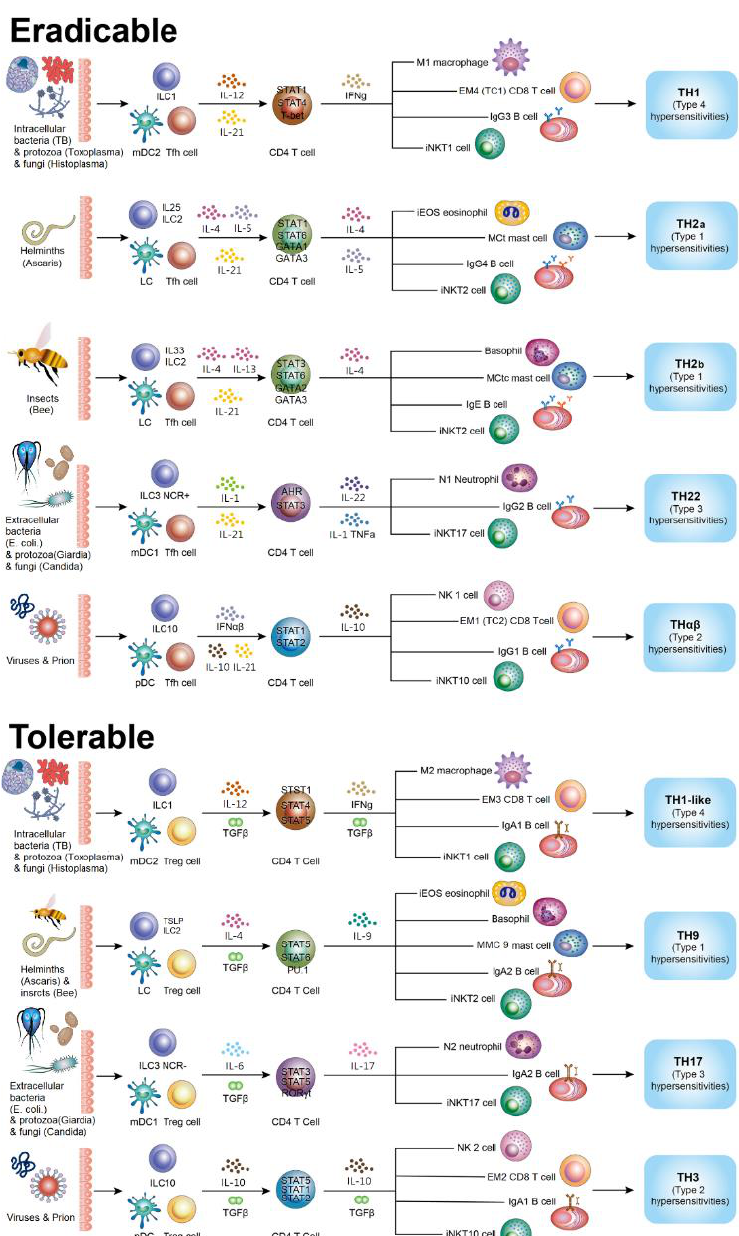
Figure 3. The framework of host immunological pathways. Host immune responses can be divided into eradicable immune responses and tolerable immune responses. Eradicable immune responses can be divided into TH1, TH2 (TH2a and TH2b), TH22, and TH αβ coping with different types of pathogens. Tolerable immune responses can be divided into TH1-like, TH9, TH17, and TH3 coping with different types of pathogens. Reprinted from Ref.